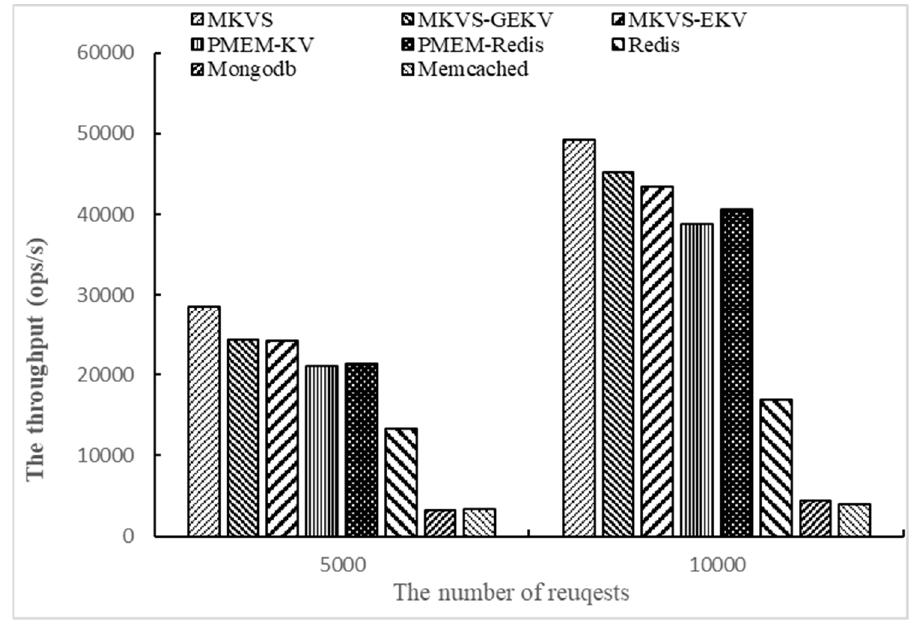
Figure 6. The throughput of changing the number of access operations with Workloada.